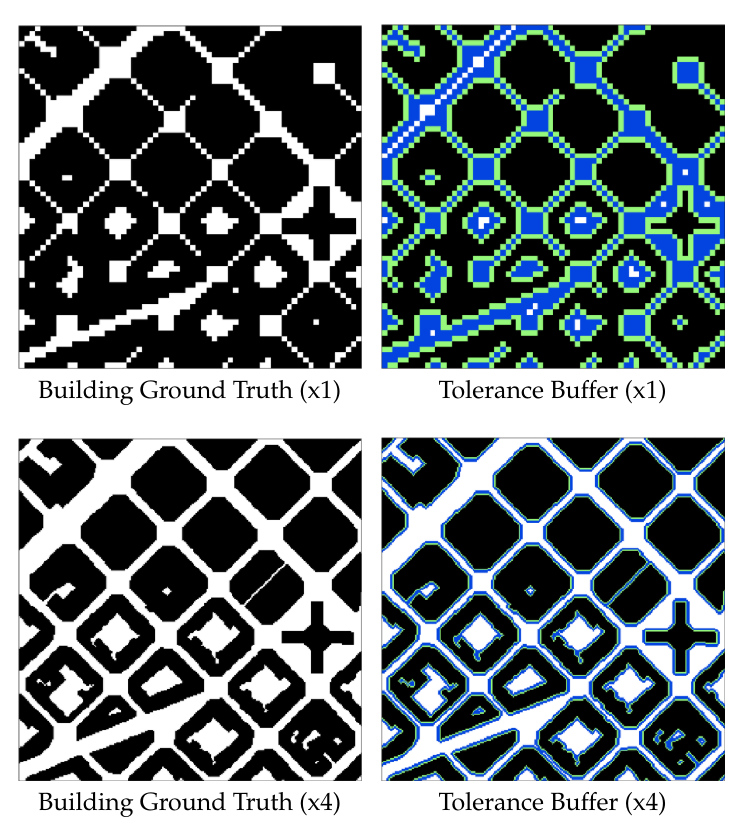
Figure 5. Tolerance buffer composition for the building label for a patch of 256 × 256 pixels at both 10 m (x1) and 2.5 m (x4). The erosion is shown in green whereas the dilation is shown in